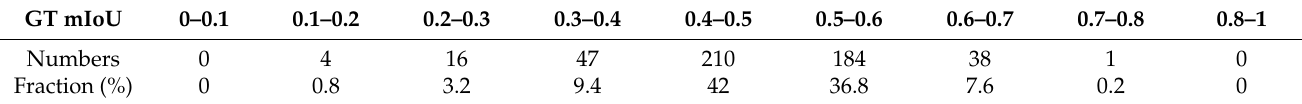
Table 2. Cityscapes test set—distribution of GT mIoU.